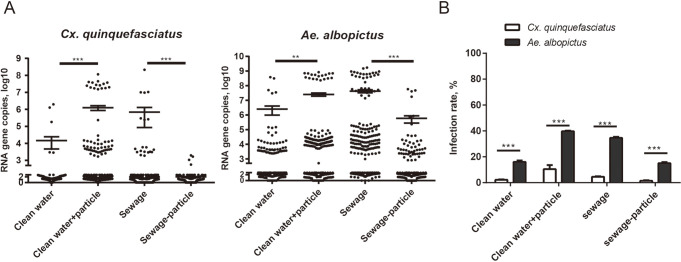
Particulate matter in sewage enhances YCV infectivity of Cx. quinquefasciatus and Ae. albopictus.Larvae (3rd-4th instar) were bred in clean water, clean water+particles, sewage, or sewage-particles with YCV (final YCV titer was 104 pfu/ml). (A) YCV RNA titers of Cx. quinquefasciatus (left) and Ae. albopictus (right) were detected by qRT-PCR 8 days after emergence. One dot represents one mosquito. The results are expressed as the mean ± SEM. (B) Infection rates. The results were analyzed using the unpaired t-test. A P value of < 0.05 indicates statistical significance. P < 0.05, *; P < 0.001, ** and P < 0.001, ***.